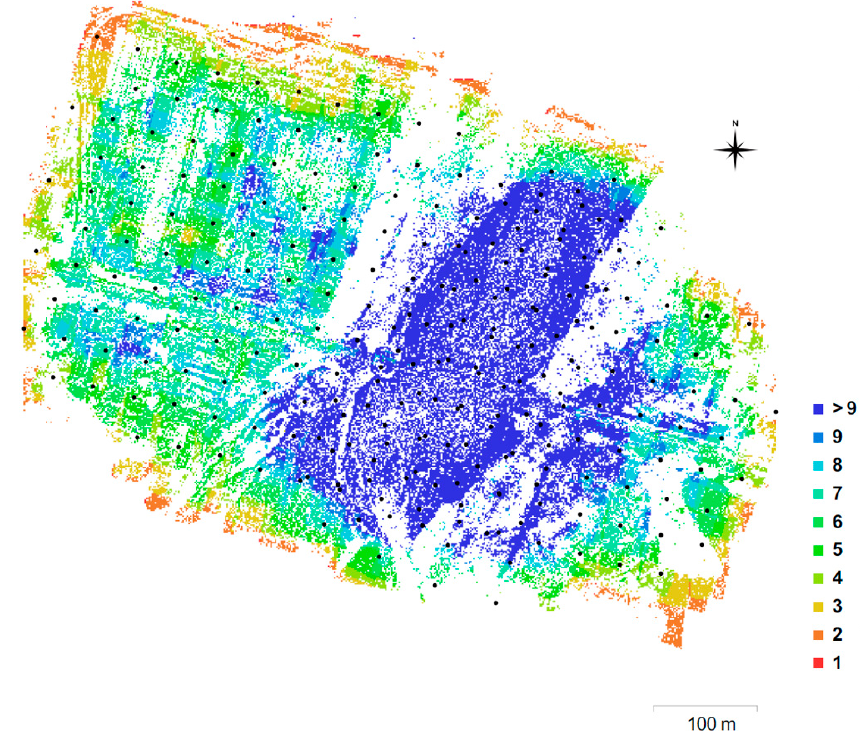
Figure 3. The camera locations (black dots) and the colour-coded image overlap of the eBee block flown about 100 m above the riverbed. Cross strips are included.